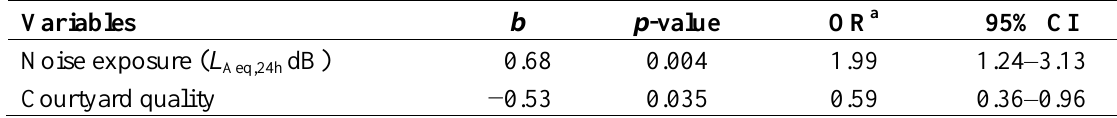
Table 4. Results of multiple logistic regression analysis with 95% confidence intervals predicting noise annoyance from noise exposure and courtyard